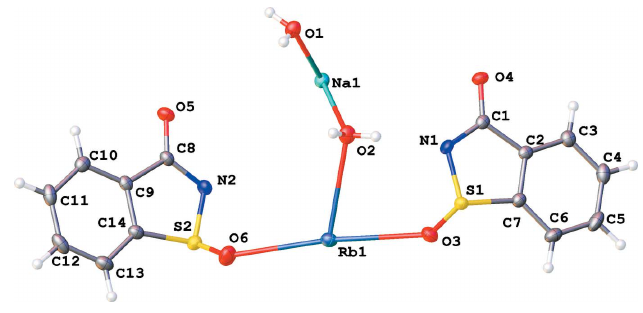
Figure 1 The numbering scheme for the title compound with 50% probability displacement